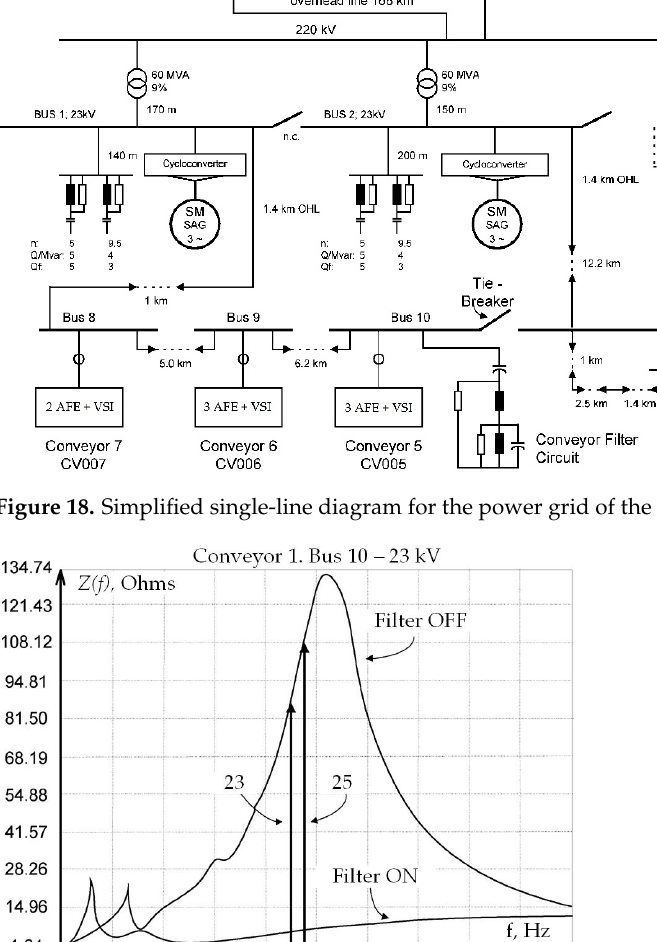
Table 2. Voltage quality indicators in metal plant power supply systems with FC-AFEs and resonant phenomena.